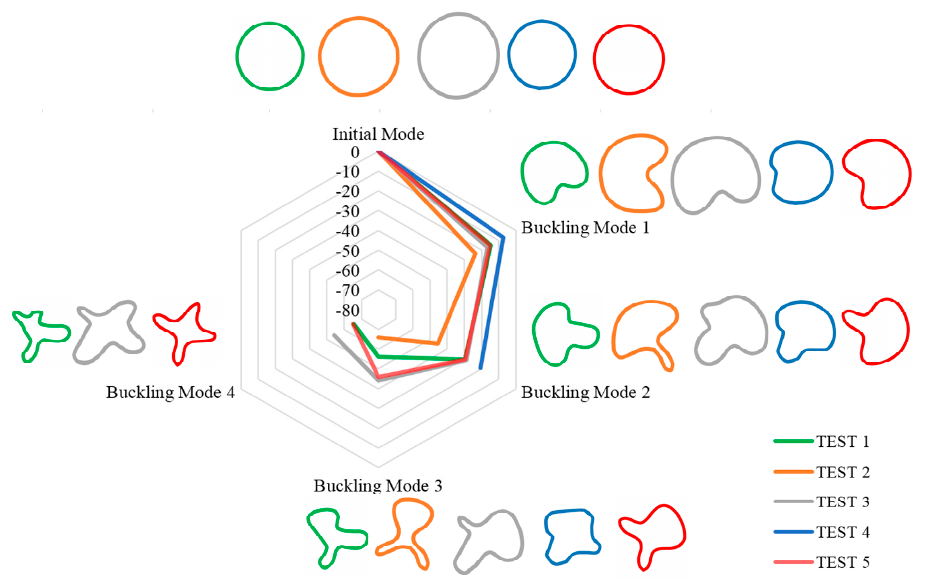
Figure 8. Reduction of the flow section in several buckling modes.